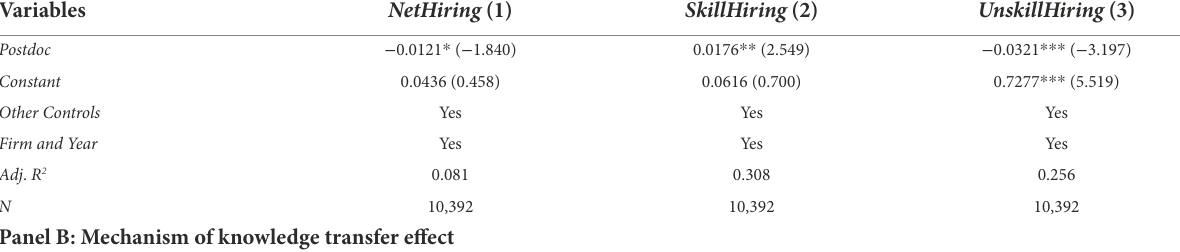
Panel B: Mechanism of knowledge transfer